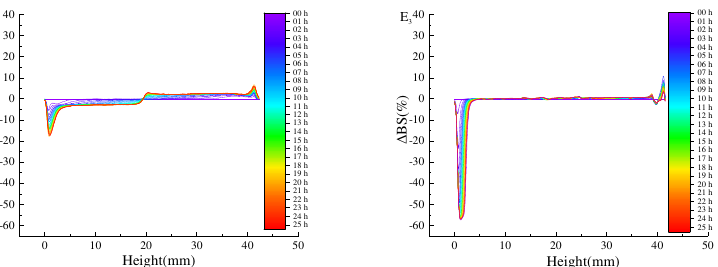
Figure 5. The change of ∆ BS under different particle concentrations under the same oil phase volume ratio. (The ∆ BS of the Pickering emulsion was measured at 0 h intervals for 25 h across the height of the samples. The blue line was detected at 0 min and the red line was at 25 h. ( A 0 ) 15 mg/mL initial Pickering emulsion, ( B 0 ) 20 mg/mL initial Pickering emulsion, ( C 0 ) 25 mg/mL initial Pickering emulsion, ( D 0 ) 30 mg/mL initial Pickering emulsion, ( E 0 ) 35 mg/mL initial Pickering emulsion, ( A 3 ) 15 mg/mL Pickering emulsion with three freeze-thaw cycles, ( B 3 ) 20 mg/mL Pickering emulsion with three freeze-thaw cycles, ( C 3 ) 25 mg/mL Pickering emulsion with three freeze-thaw cycles, ( D 3 ) 30 mg/mL Pickering emulsion with three freeze-thaw cycles, ( E 3 ) 35mg/mL Pickering emulsion with three freeze-thaw cycles).